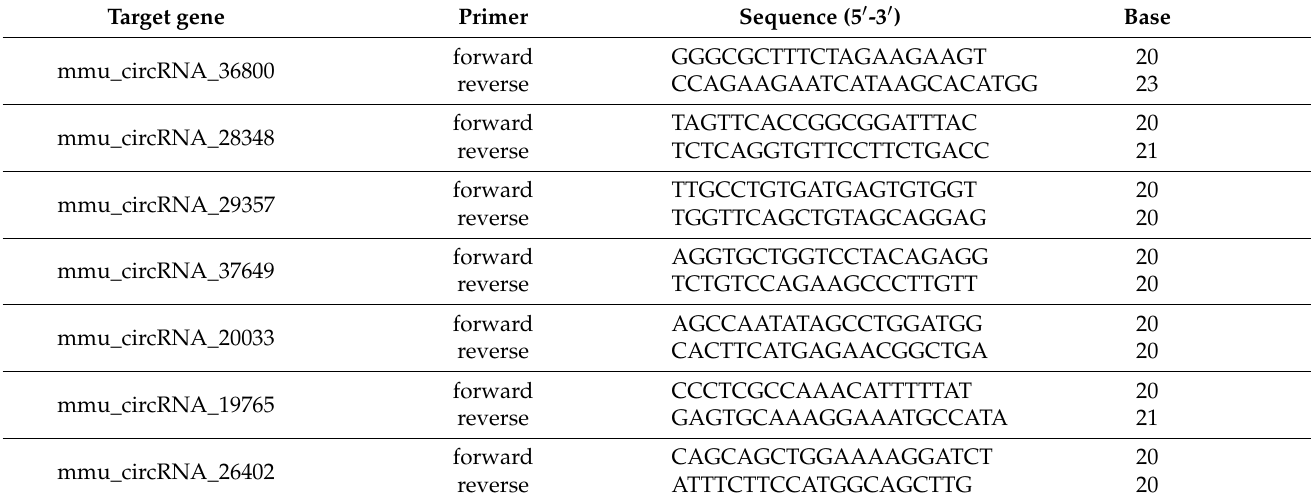
Table 1. Primers of